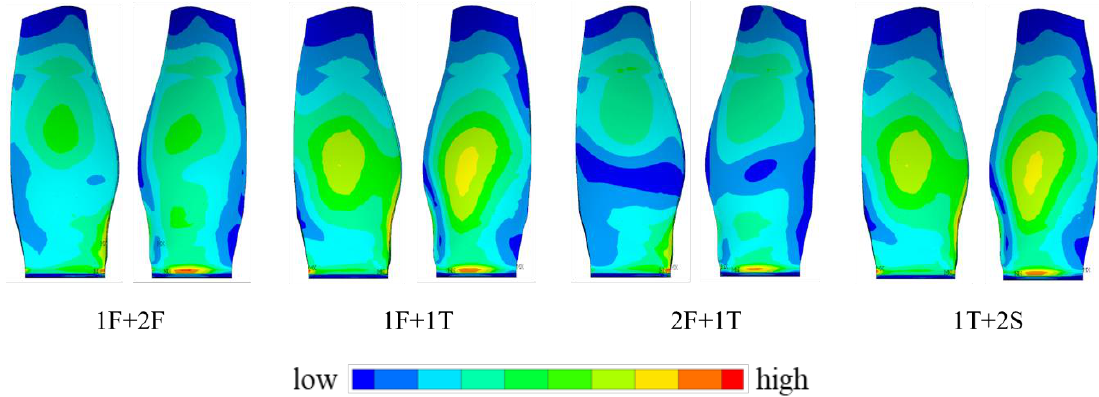
Figure 12. The superimposed modal strain contour.